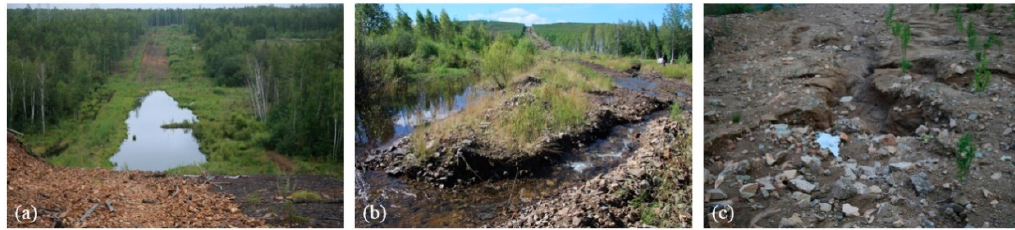
Figure 5. (a) Distribution of ponds from the field survey, (b) image extraction, and (c) water erosion along the CRCOP (the reference system is WGS-1984).